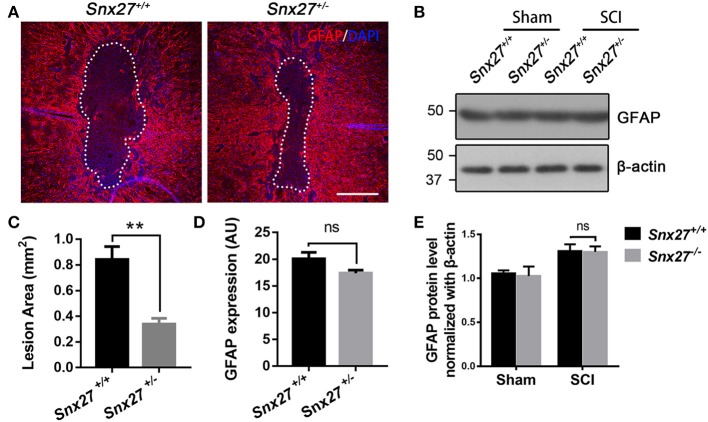
SNX27 haploinsufficiency reduces the size of lesion region without influencing gliosis after SCI. (A) Representative images of GFAP staining indicating the lesion region 7 days post injury, n = 6, Scale bar = 200 μm. Dashed lines indicate the lesion area. (B) Western blot analysis of GFAP in the spinal cord of Snx27+/+ mice and Snx27+/− mice 7 days post injury. (C,D) Quantification of GFAP-negative area (lesion region) and GFAP protein expression, n = 6. (E) Quantitative analysis of GFAP expression, n = 3. Values are expressed as mean ± SEM and were evaluated by Student's independent sample t-test. **p < 0.01.